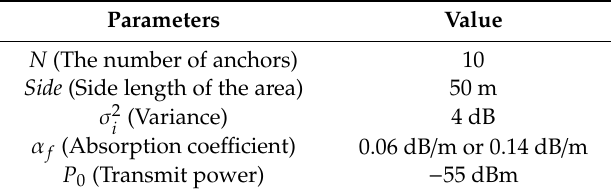
Table 8. Parameters in the comparison of cumulative distribution function (CDF) of (cid:107) ˆ x − x (cid:107) .